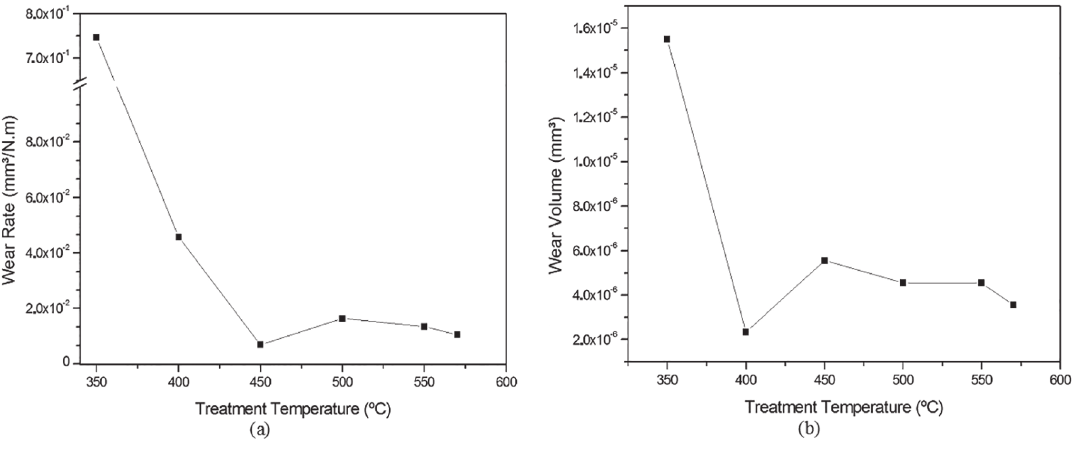
Figure 9: (A) Wear rate and (B) wear resistance of the material as a function of the nitriding temperature.